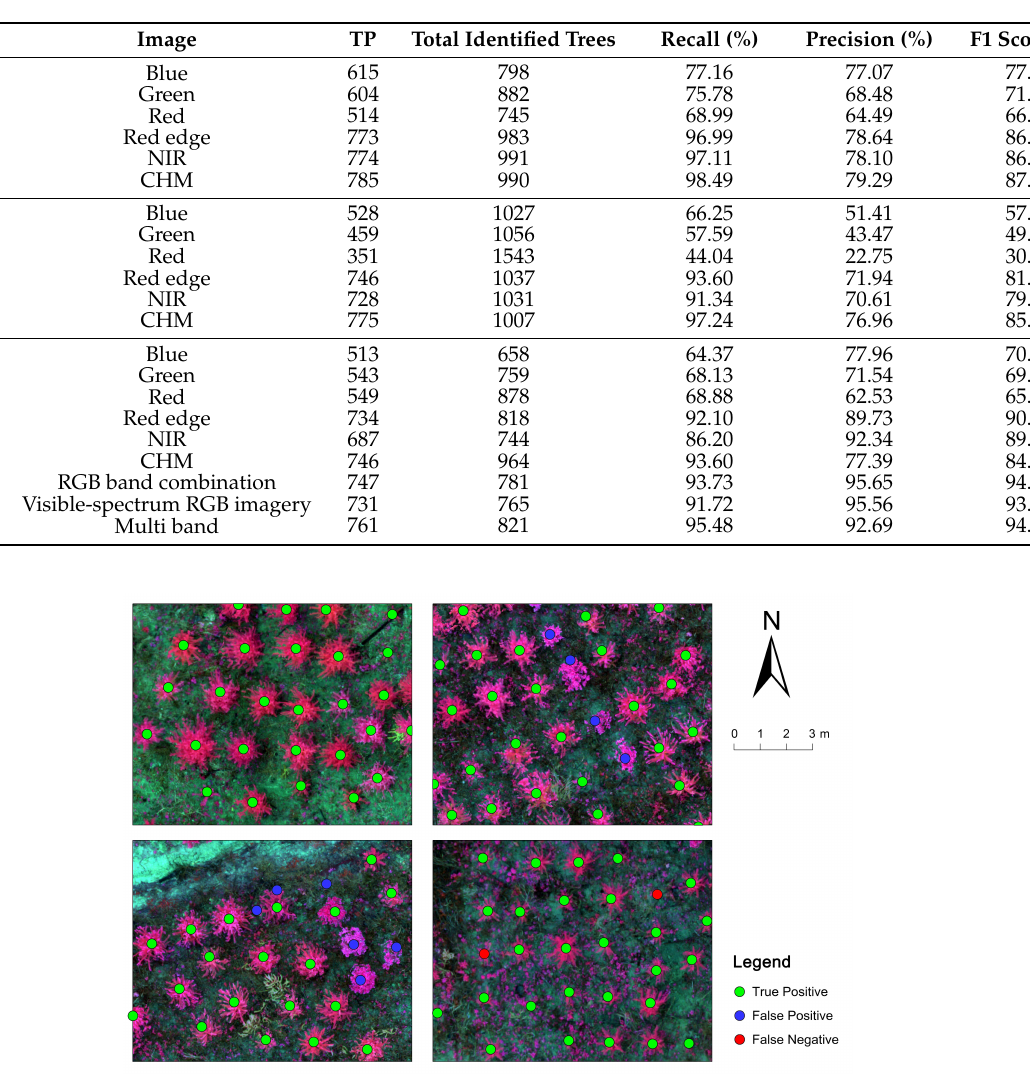
Figure 5. Example of individual tree detection using the CHM for LM algorithm. Green dots represent the correctly identified trees; Blue dots represent the falsely detected trees (e.g., broad-leaved trees); Red dots represent the omitted